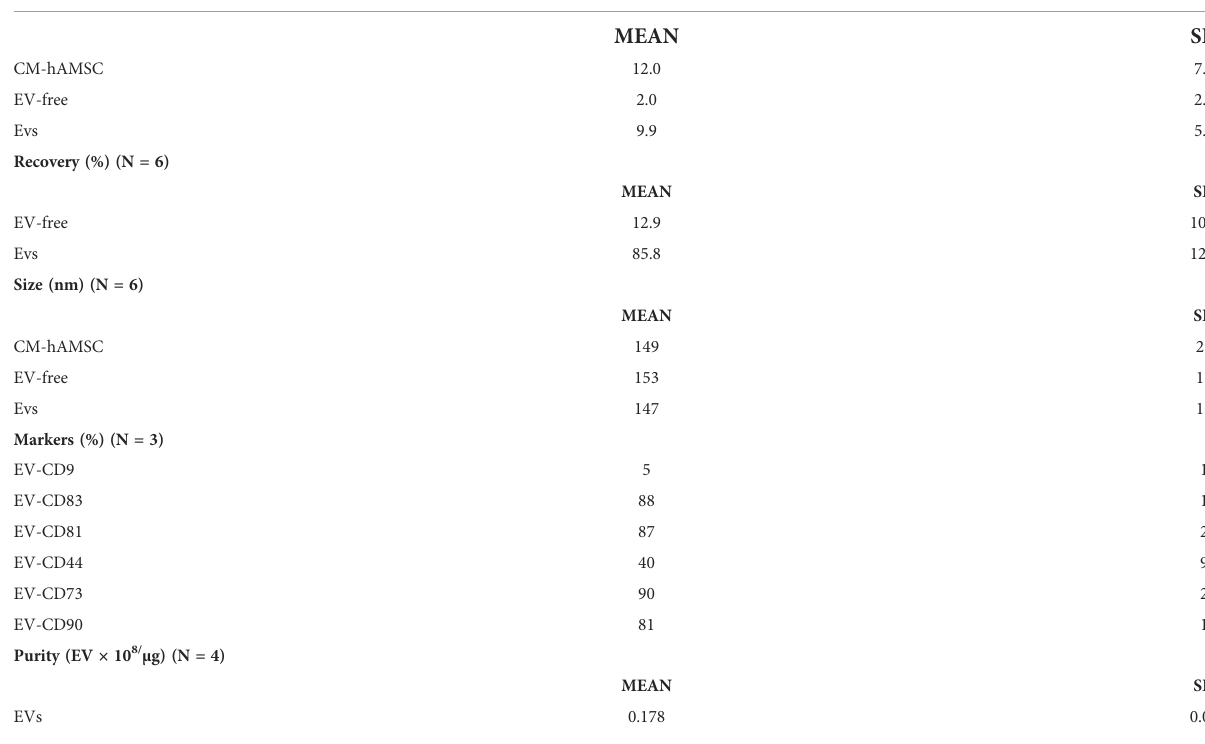
TABLE 1 Summary table for concentration, recovery, size, and marker expression of EVs isolated from hAMSC-CM. EV/ml (×10 8 ) (N =